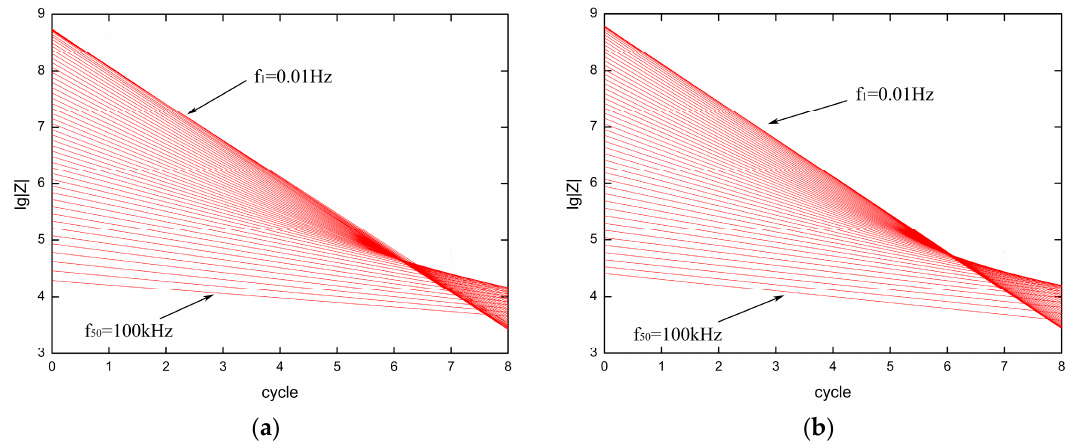
Figure 7. The fitting results of the two specimens using improved degradation kinetic model: ( a ) Plate 1#; ( b ) Plate 2#.